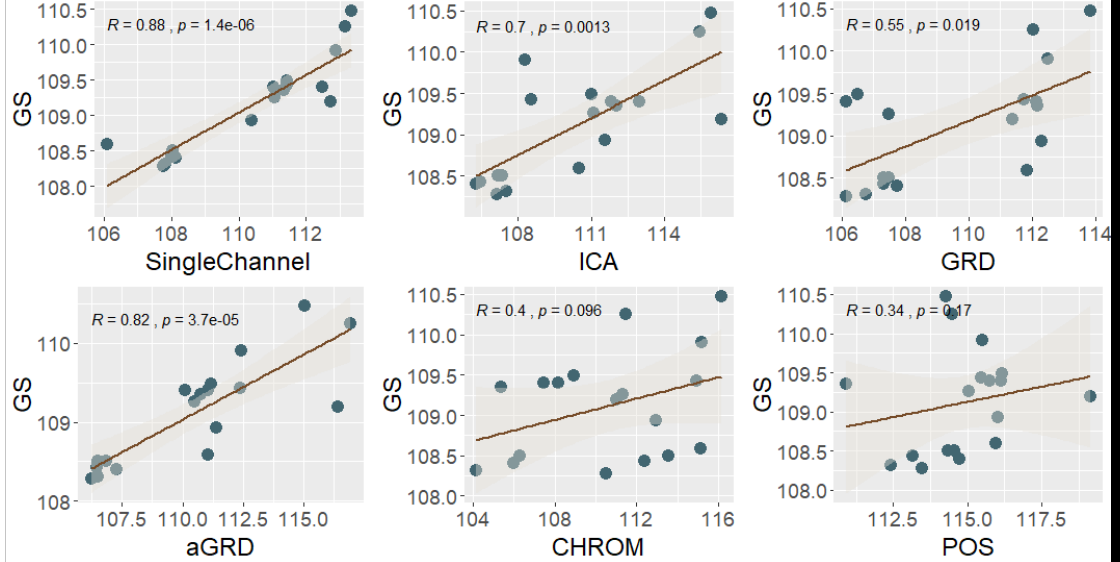
Figure 5. Correlation between monitoring of HR on the anaesthetized pig using the gold standard (GS) vs. using a single channel, combination of the three channels and ICA.